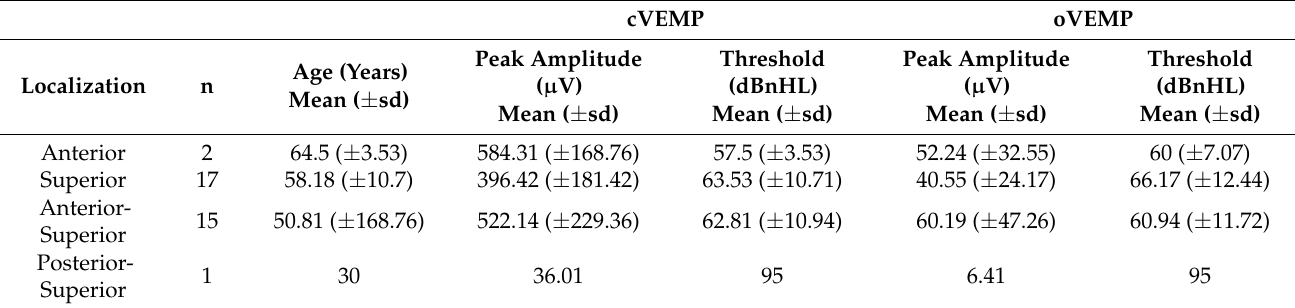
Table 1. Description of the different VEMP findings for the different SSCD locations based on CT-scan findings.